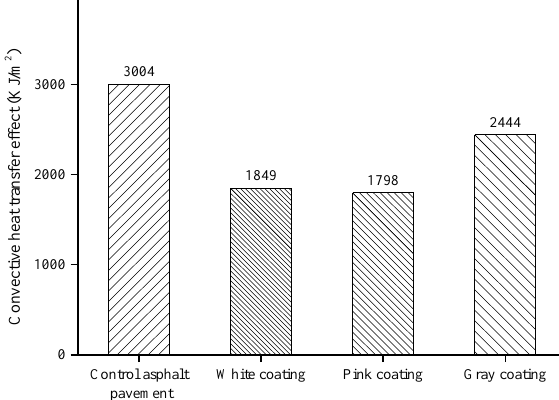
Figure 12. Heat convection effect of different asphalt pavement.